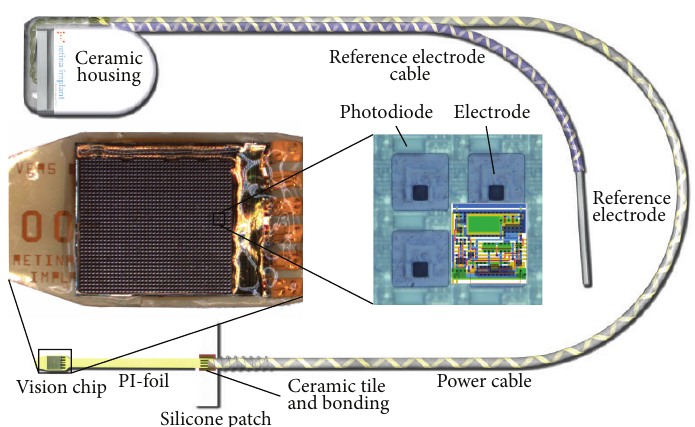
Figure 1: The Retina Implant Alpha IMS consists of the vision chip (multiphotodiode array, 4 pixels magnified in the center) on a polyimide foil (PI-foil, both placed subretinal) and a power supply cable connecting the microchip with the receiver coil in a ceramic housing and the reference electrode placed subdermally at the temple and retroauricular region.